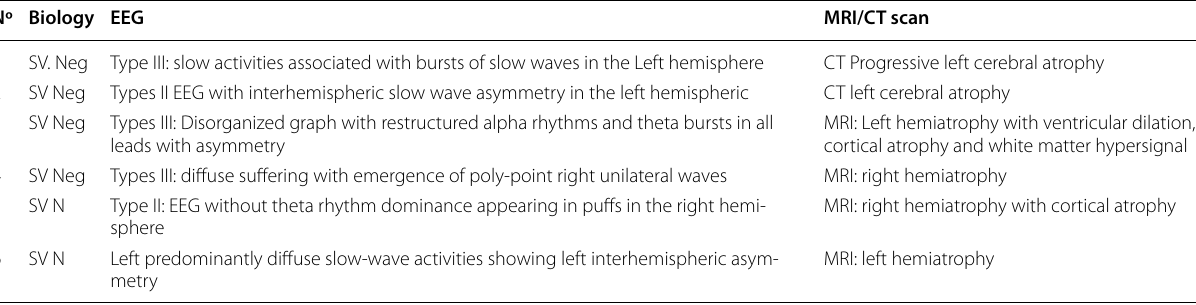
Table 2 Biological, EEG, Brain MRI/CT scan data Nº Biology EEG MRI/CT scan 1